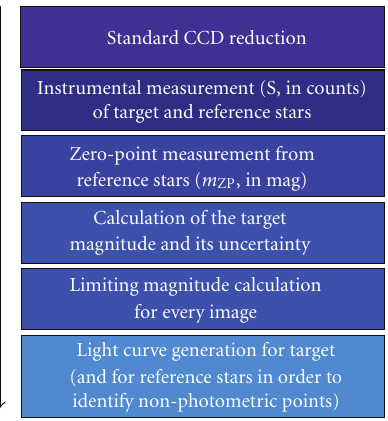
Figure 1: Flowchart of Watcher’s photometry pipeline.